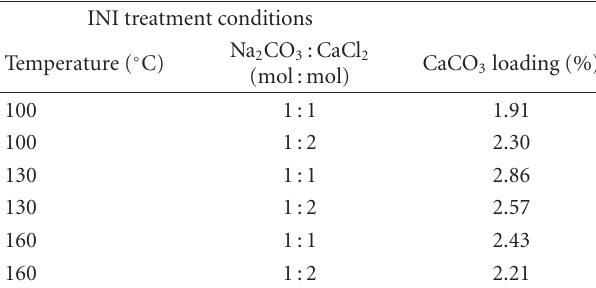
Table 1: CaCO 3 loading percentages of the INI-treated